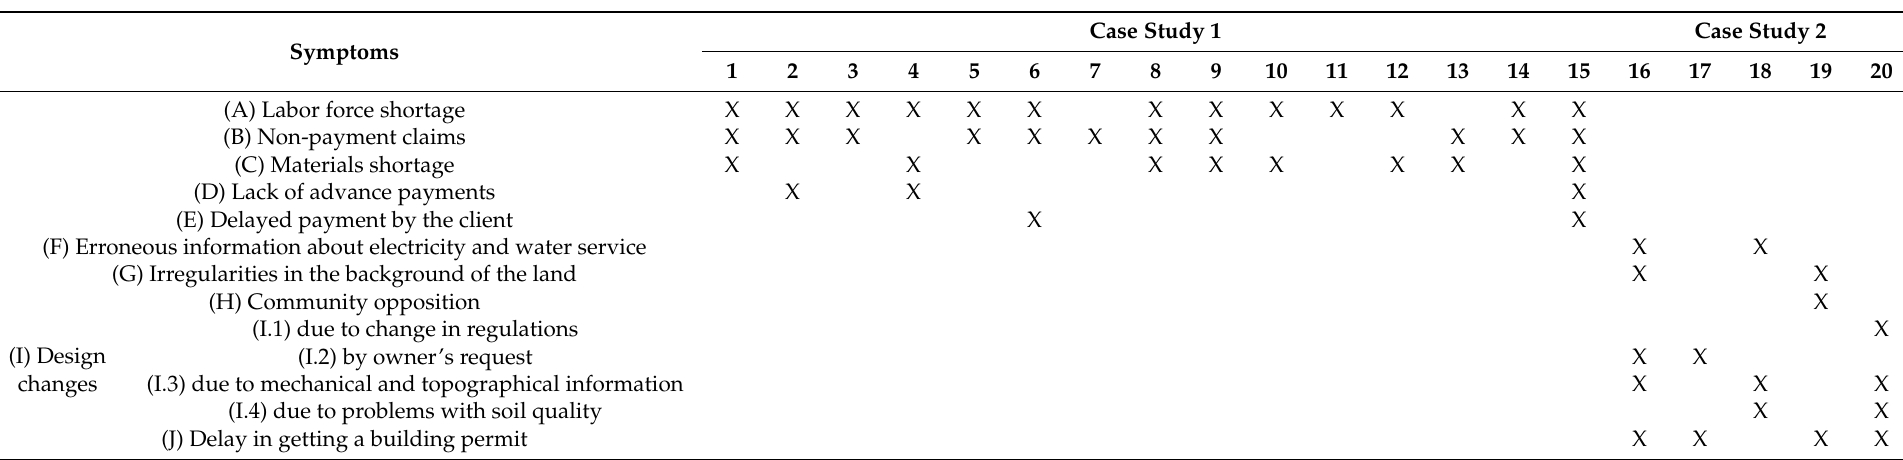
Table 3. Pattern matching